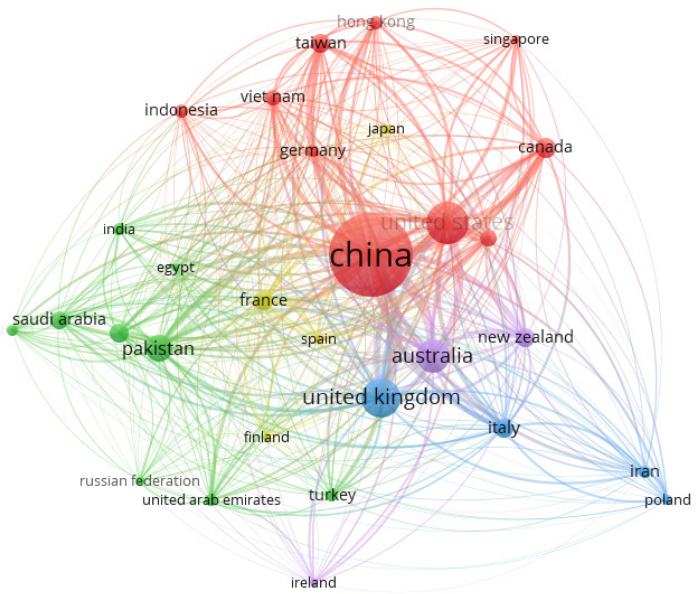
Figure 6. Bibliographic coupling based on documents. Source: Scopus/VOSviewer.